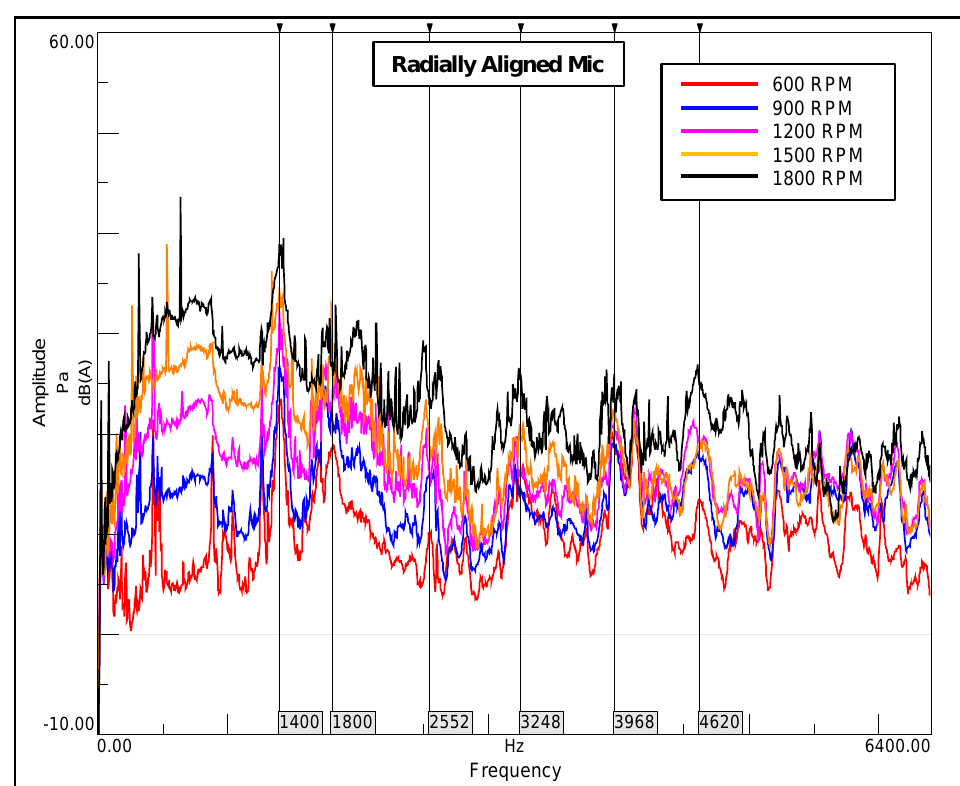
Figure 9. Acoustic auto-power spectrum from a microphone aligned in motor’s radial direction with RMS dB(A) values at 600, 900, 1200, 1500, and 1800